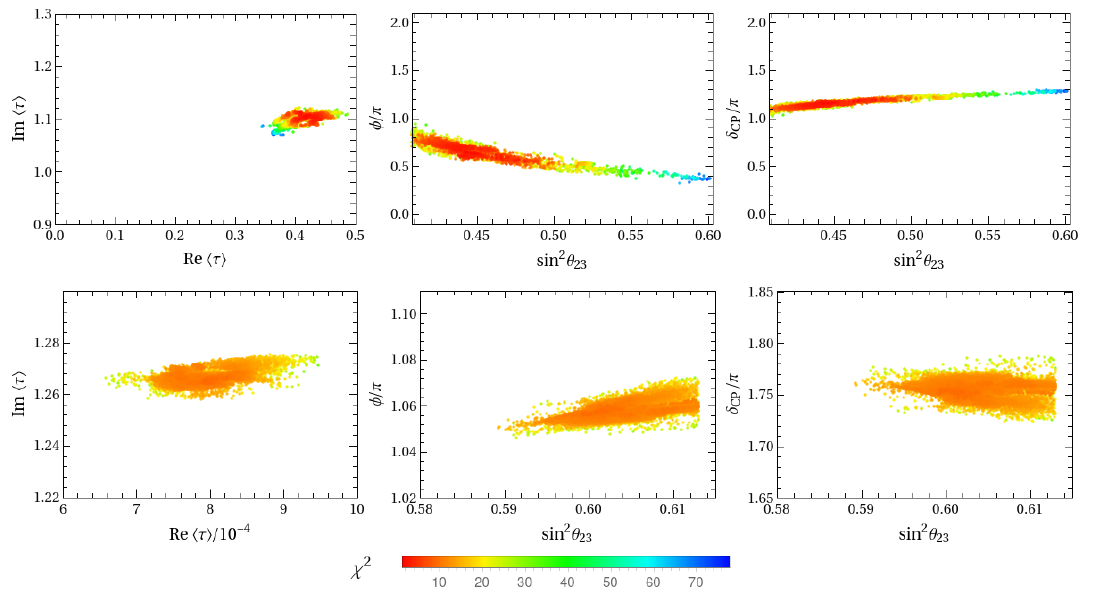
Figure 2. Values of the complex modulus τ compatible with experimental data, and correlations between sin 2 θ and the CP-violating phases δ and φ . The upper (lower) panels correspond to 23 CP the case in which the neutrino mass specturm is NO